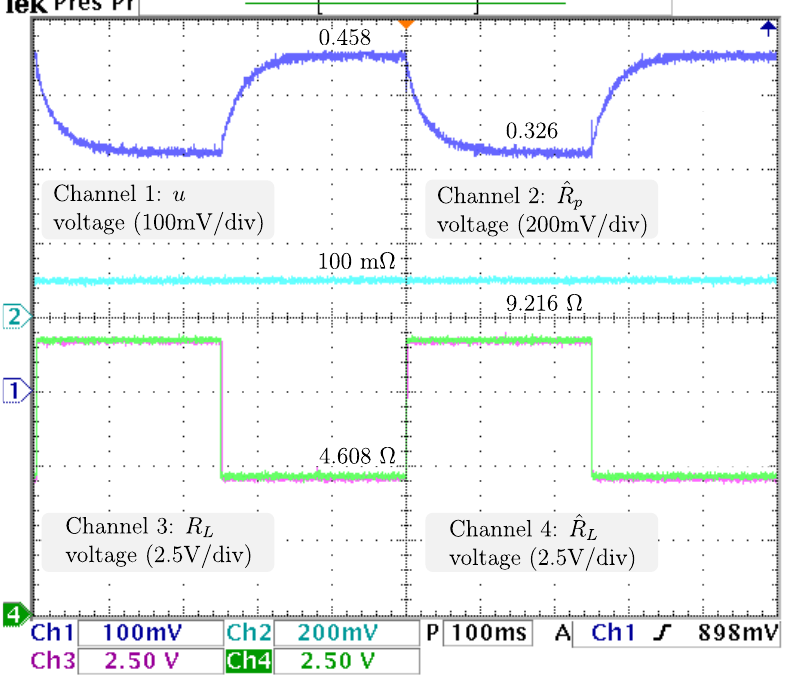
Figure 7. Real -time results for sudden load voltage changes. From top to bottom: u , the control signal; ˆ R p , the estimation of the parasite resistance; R L , the load; and ˆ R L = 1/ˆ θ L , the estimation of the load through its